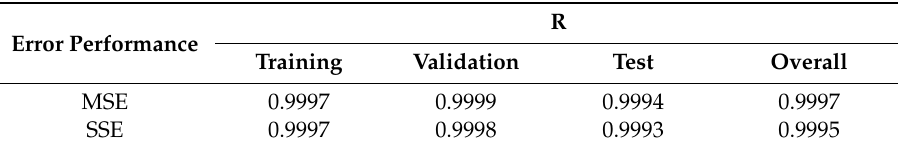
Table 3. MSE and SSE results during training.